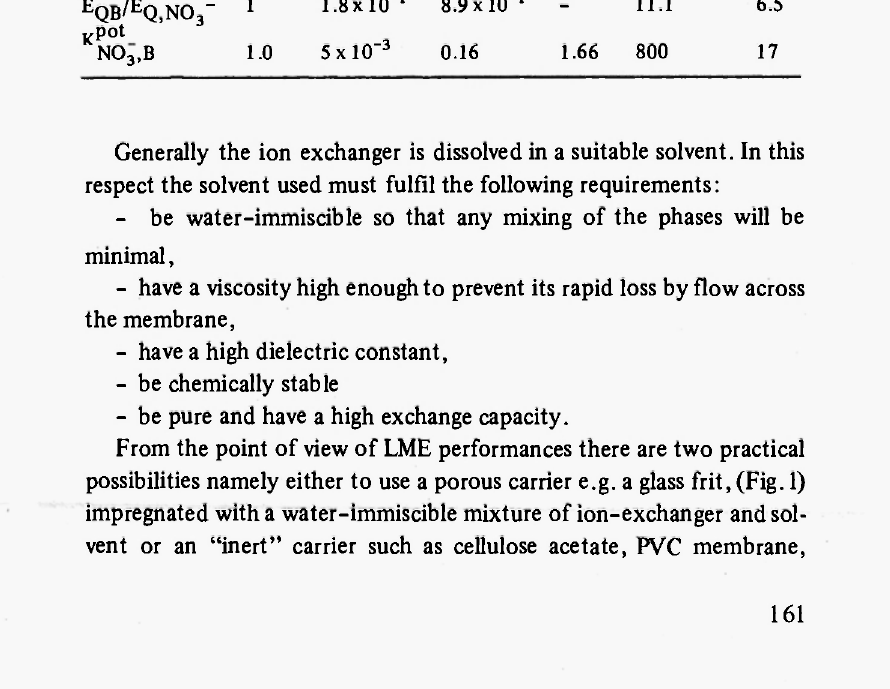
Ion pair extraction constants of the tetrabutyl-ammonium ion compared with selectivity constants K ^- of a nitrate 3> ion-selective electrode with tridodecylhexadecylammonium nitrate